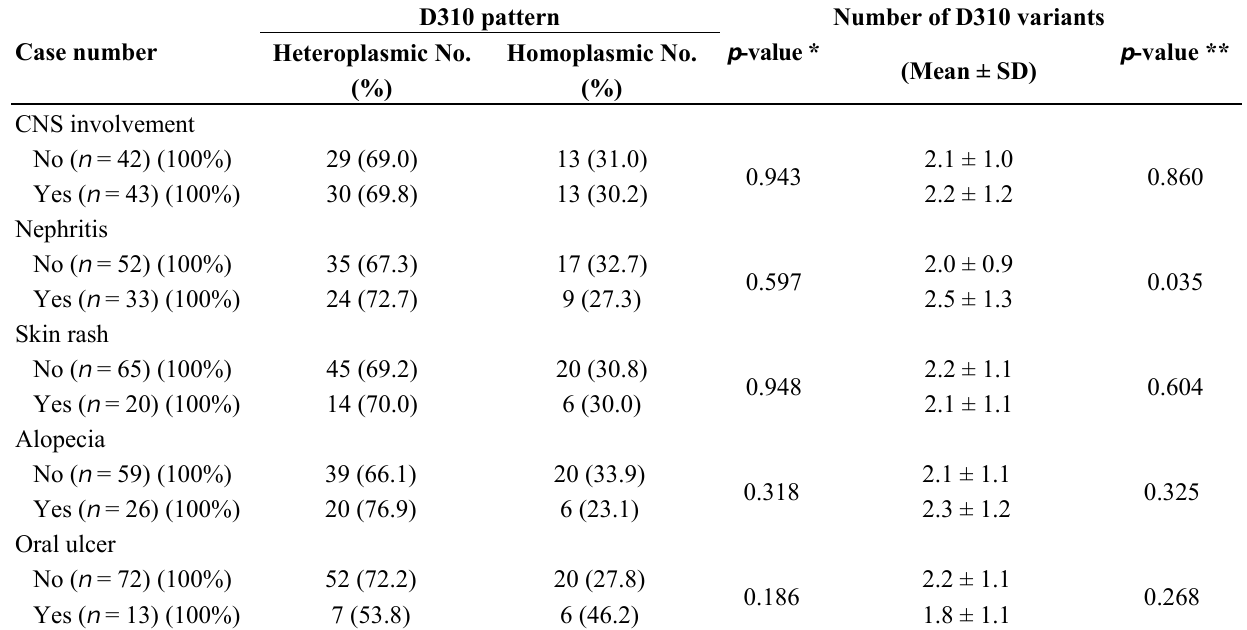
Table 3. D310 heteroplasmy in SLE patients with different clinical